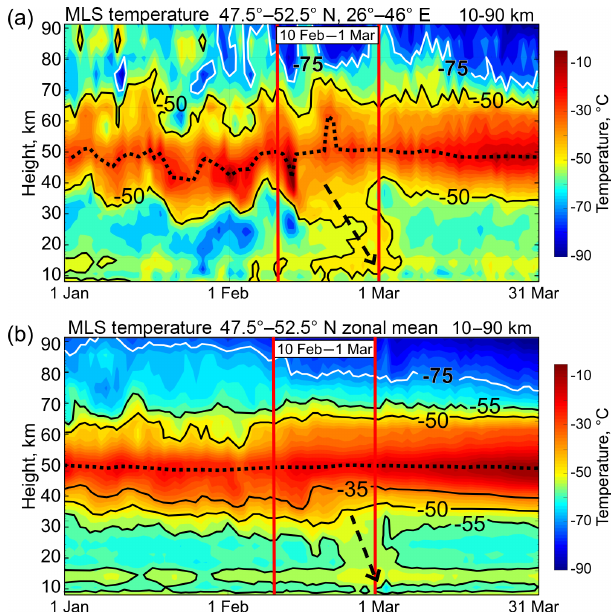
Figure 6. MLS temperature profiles (a) over the Kharkiv region and (b) zonal average in the zone 47.5–52.5 ◦ N. Dashed arrows indicate downward